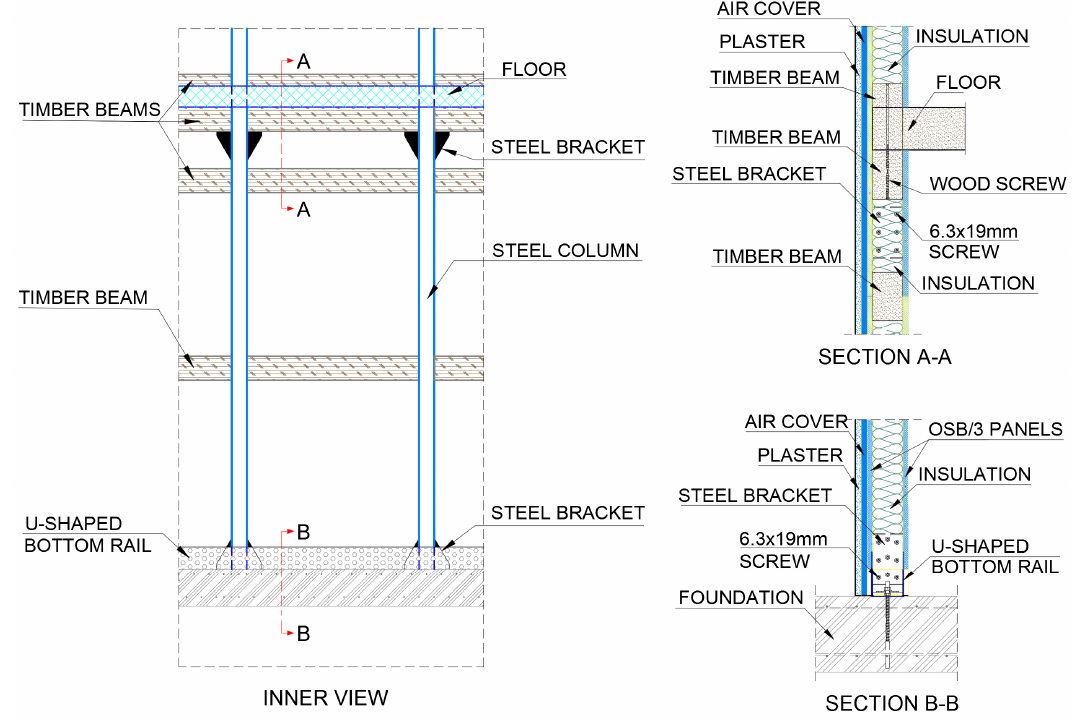
Figure 1. Details of the shear ‐ wall system: inner view of a wall module and detailed sections.